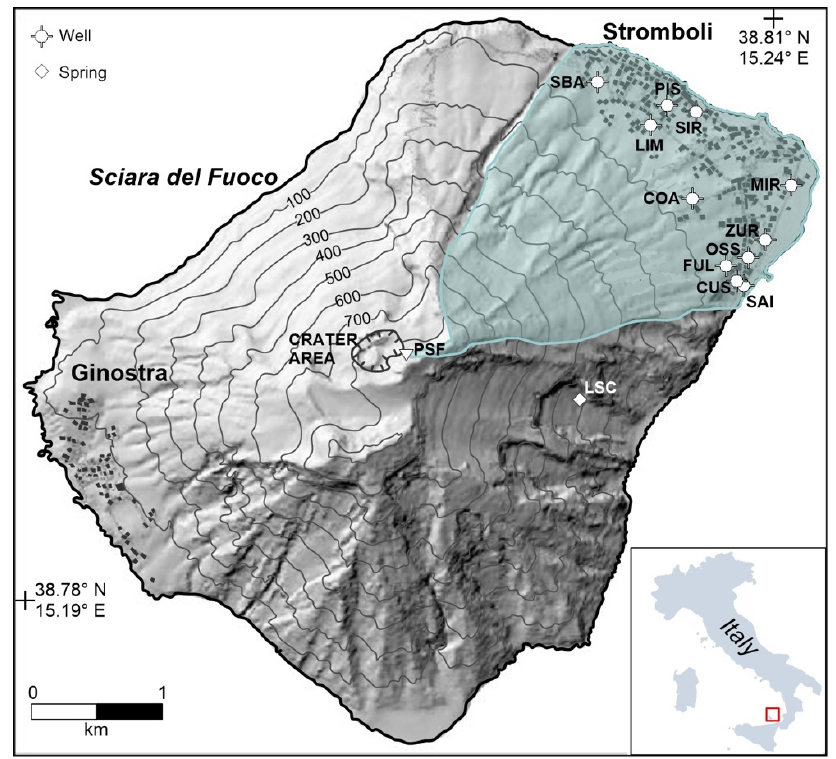
Figure 1. Map of Stromboli Island showing the study area (shaded polygon) and the location of water wells (circles), a spring (diamond), and rain collectors (triangles). water wells (circles), a spring (diamond), and rain collectors